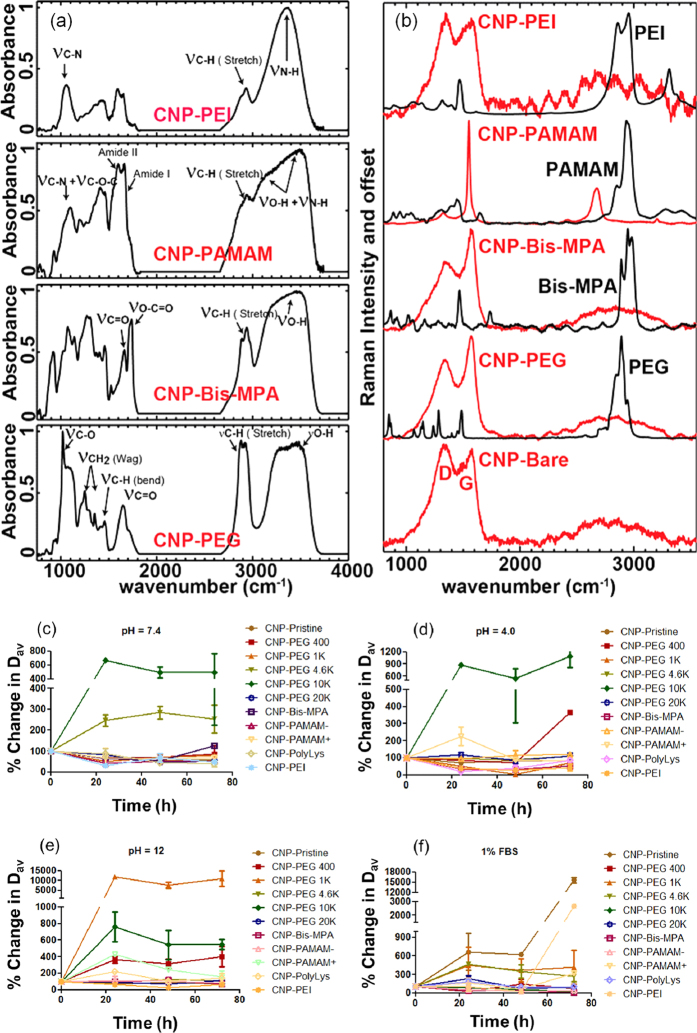
Chemical bonding and molecular structures identified by FT-IR and Raman spectroscopy.(a) FT-IR traces of CNP-PEI, CNP-PAMAM−, CNP-Bis-MPA, CNP-PEG, respectively (top to down). (b) Overlaid Raman spectra of PEI and CNP-PEI, PAMAM− and CNP-PAMAM−, Bis-MPA and CNP-Bis-MPA, PEG and CNP-PEG and CNP-bare, respectively (top to down). (c–f) Stability of CNPs in acidic, neutral and basic pH and in presence of fetal bovine serum (FBS). Particle stability was followed by hydrodynamic diameter determination at various time points including 0, 24, 48 and 72 h. Dav = hydrodynamic diameter.